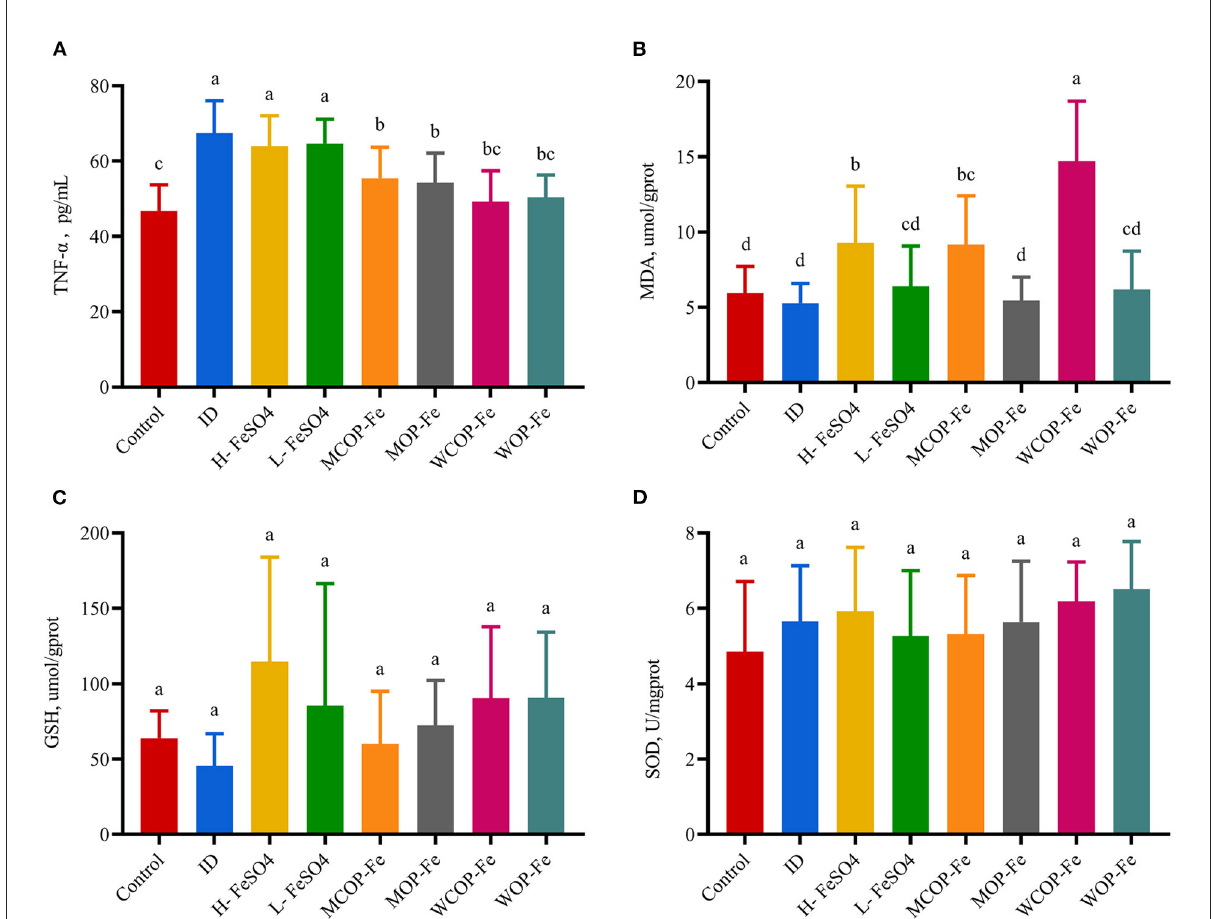
FIGURE4 Effect on oxidative stress biomarkers in liver tissue and TNF- α in serum of IDA pregnant rats. Values marked with different letters show significant differences. (A) Effect on tumor necrosis factor α (TNF- α ); (B–D) Effect on the malondialdehyde (MDA), geduced glutathione (GSH) and superoxide dismutase (SOD). ID, iron deficiency anemia model group (4 ppm FeSO 4 ); H-FeSO 4 , 400 ppm FeSO 4 ; L-FeSO 4 , 40 ppm FeSO 4 ; MCOP-Fe, 400 ppm marine fish oligopeptide iron complex; MOP-Fe, 40 ppm marine fish oligopeptide iron complex; WCOP-Fe, 400 ppm